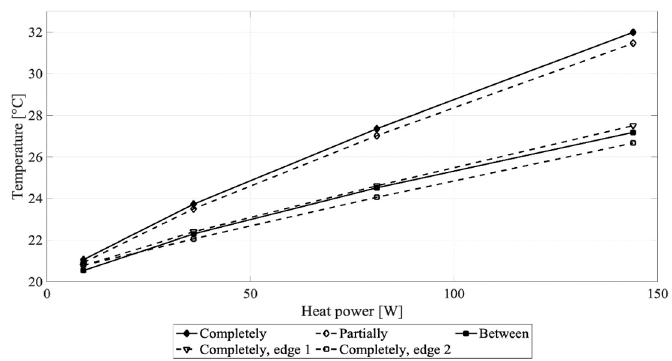
Figure 4. Analysis of thermocouple position on the heating foil at different levels of heating power. Placement completely on, partially on, and between the electrically conducting heating elements was tested in the middle of the cavity. Placement on the edges of the heating foil width was also included.